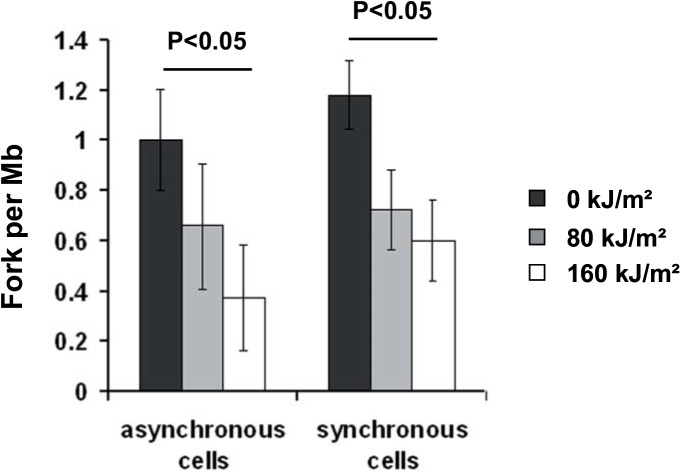
The firing of origins is reduced in response to UVA-induced ROS.Asynchronous or S-phase synchronised (condition S4R, see Material and Methods) cells were exposed to 80 and 160 kJ/m2 of UVA in MEMi. IdU and CldU were then sequentially added to the medium 4 h (asynchronous cells) or 2 h (S-phase cells) after UVA radiation. The forks density is defined as the ratio between the number of CldU-IdU-CldU signals (Red-Green-Red signals) and the length of replicated DNA. The percentage of cells in S-phase at the labeling time was determined by flow cytometry and was found to be 47% for the asynchronous population and 80% for S-phase synchronised cells. The data represent the mean ± sd of 4 independent experiments for A and 3 independent experiments for B (excepted for the dose of 80 kJ/m2 of UVA for which only 2 data were available).